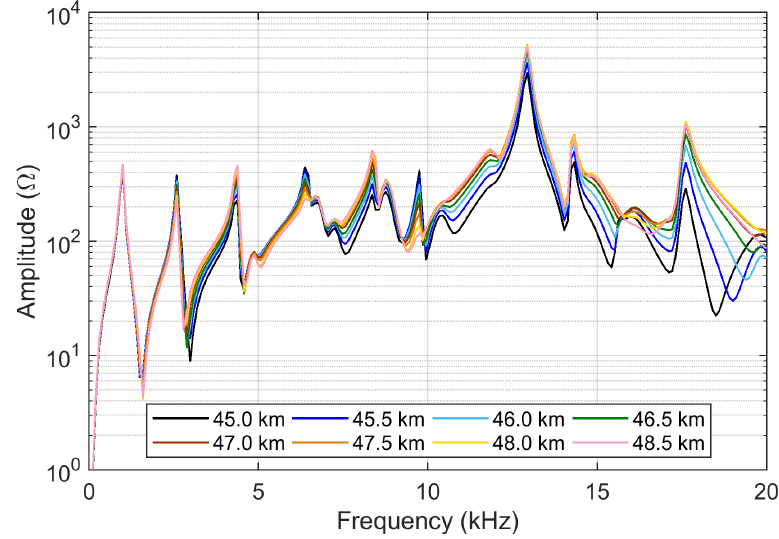
Figure 1. Line impedance curves of test case 1 [13] for positions along the line from 45.0 km to 48.5 km. Note the closer similarity of curves in the last positions beyond 47 km.